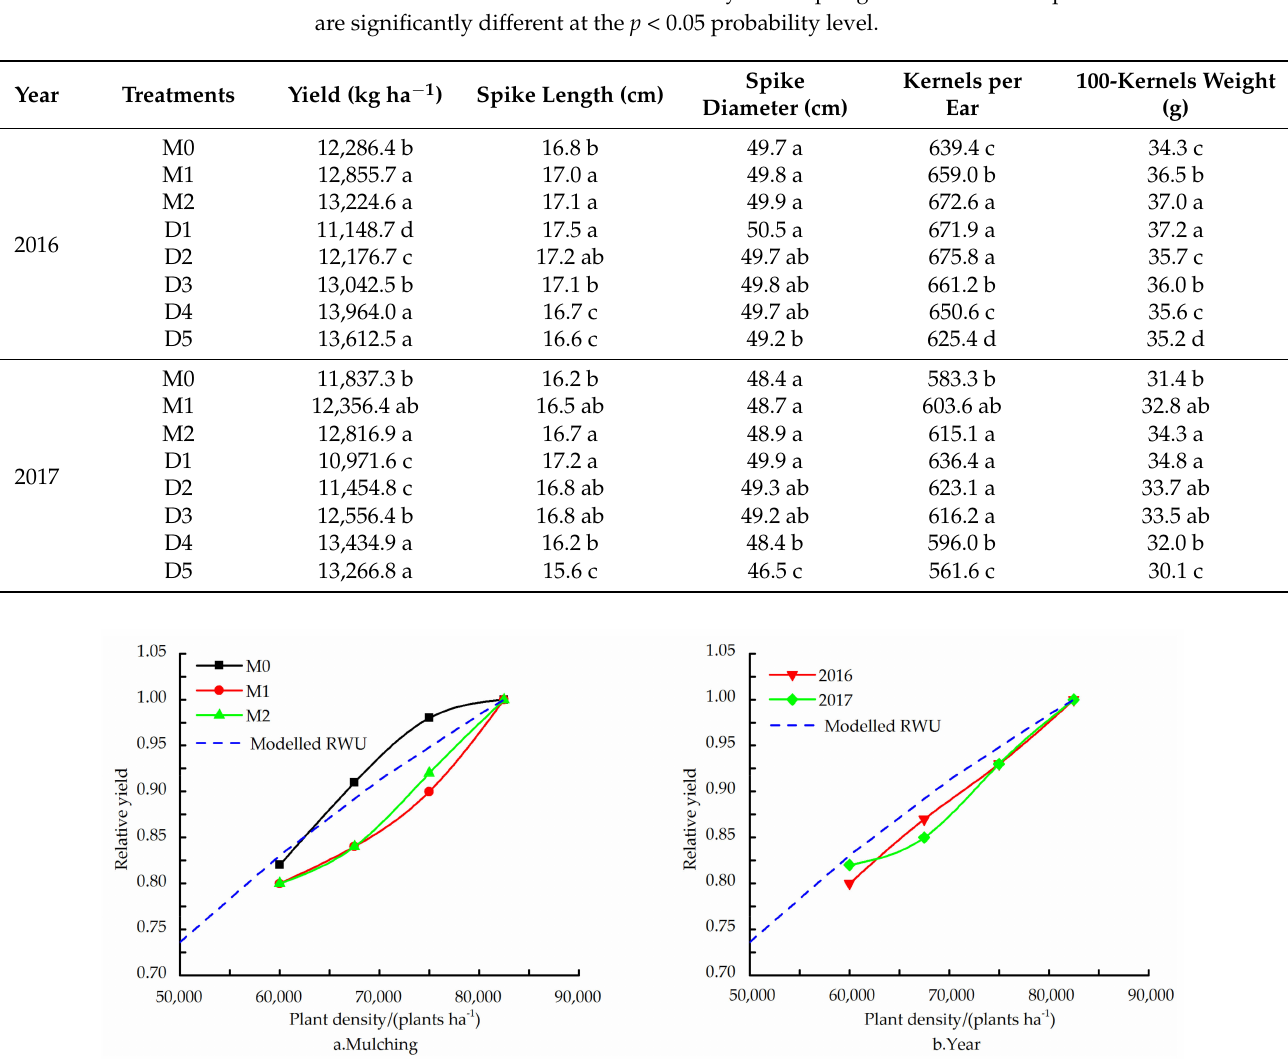
Figure 1. Relative yield, yield ( Y ) normalized by the maximum yield obtained at a PD of 82,500 (D4) plants ha − 1 ( Y max ), as function of PD for no (M0), transparent (M1) and black (M2) film mulching treatment (( a ), mean of 2016 and 2017), and for the two experimental years (( b ), mean of three mulching treatments). Also shown is the Y/Y max relationship according to the fitted relative water uptake